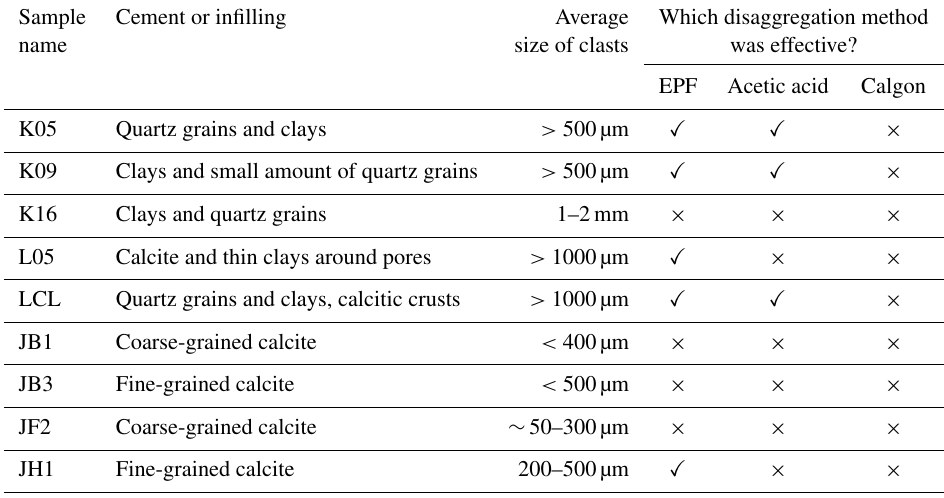
Table 4. Comparison of sample properties and relative success with different disaggregation techniques. Sample Cement or infilling Average Which disaggregation method name size of clasts was effective?